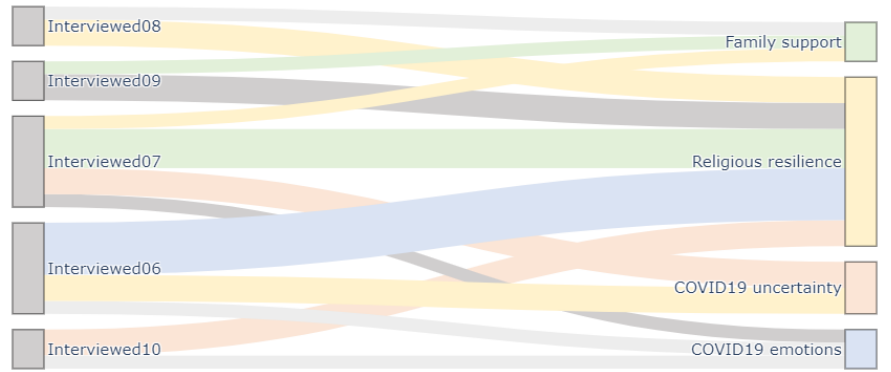
Figure 5. Sankey diagram—occurrences code groups with Respondents